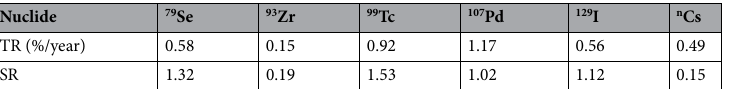
Table 7. The TR and SR of LLFPs in the LFR (with MAs) using the optimal scheme used to balance the transmutation efficiencies.